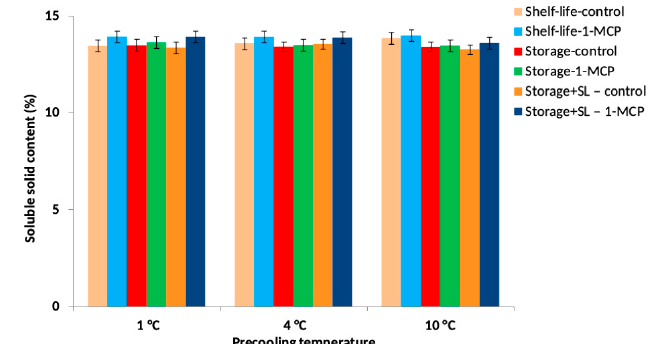
Fig. 4: Soluble solid content during experiment (SL: shelf-life). Presented values are means ± SD.